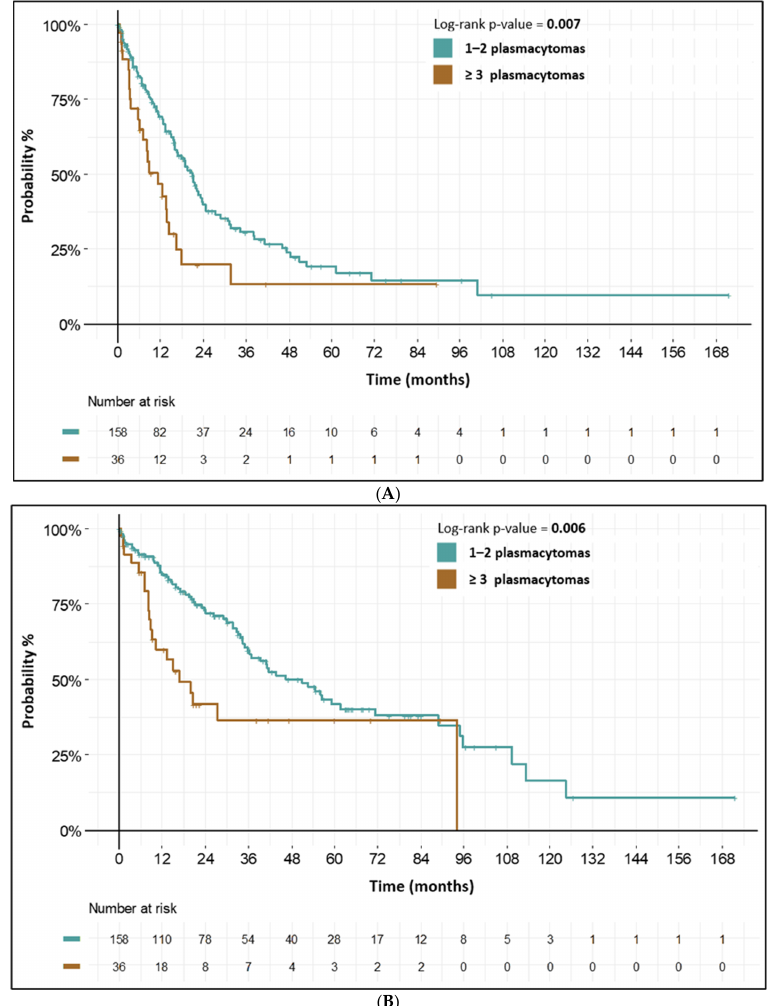
Figure 3. ( A ) PFS from 1st line—by plasmacytoma count in NDMM patients with EMD plasmacy-